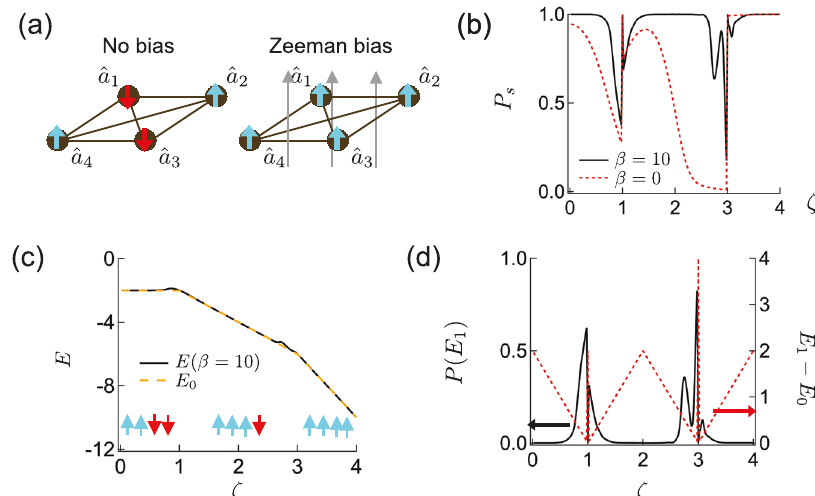
Fig. 4 Anti-ferromagnetically fully connected four degenerate optical parametric oscillators (DOPOs) with Zeeman term. a The ground state (Left) without (Right) with uniform bias. Sites with blue and red arrows show up-spin ( σ = 1) and down-spin ( σ = − 1) states respectively. b Success probability as a function of uniform Zeeman bias ζ . c Ground state energy E 0 and mean energy obtained by the simulation of β = 10 coherent Ising machine (CIM). d Probability to fi nd fi rst excitation state P ( E 1 ) (black line, left axis) and the excitation energy E 1 − E 0 (red broken line, right axis).